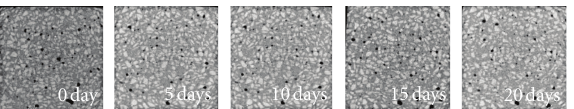
Figure 6: CT scanning images of concrete specimen conditioning in acidic solution with pH level of 1.5.